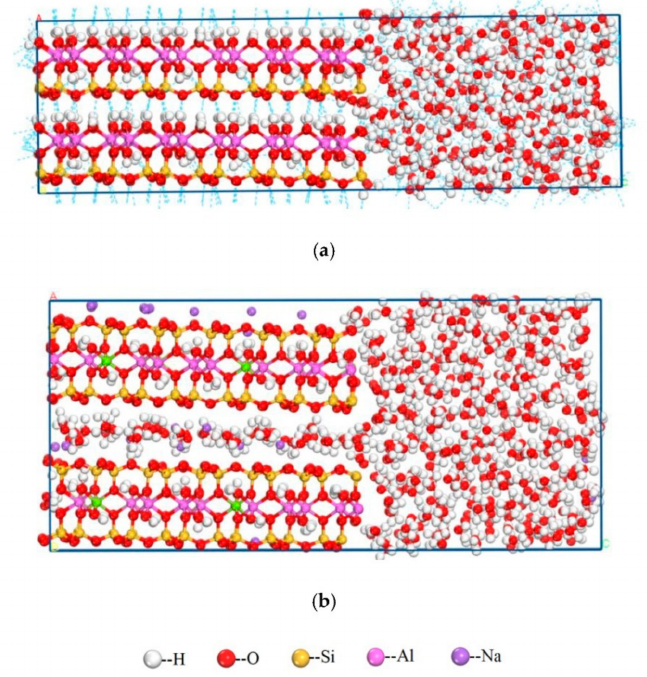
Figure 3. Example of an equilibrium snapshot from a molecular dynamics (MD) simulation of water adsorption on the side surfaces of ( a ) kaolinite and ( b ) montmorillonite at 298 K and 1 bar